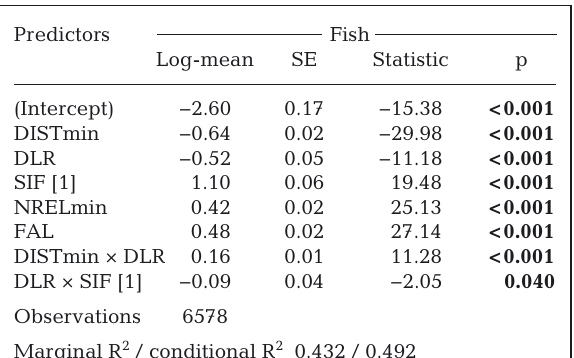
Table 2. Negative binomial model on independent variables influencing the daily number of cod detected at different salmon farms. DISTmin: closest Euclidean distance at last release to farm; DLR: days since last release; SIF: farm operational status; FAL: fish at liberty still transmitting. The treatment contrast of R was used with the intercept representing the value for farms when non-operational. Square brackets indicate a categorical variable tested against the reference variable. Only fixed effects are shown. Significant p-values are in bold (p <